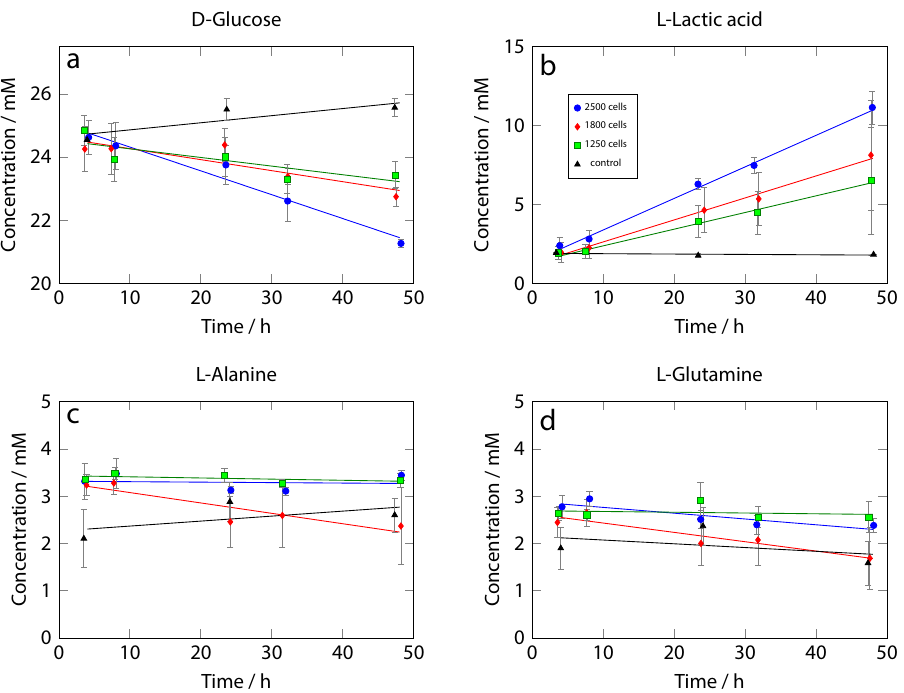
Figure 5. Metabolite concentrations over time in single spheroid culture as a function of time. d-Glucose (a) , l-Lactic acid (b) , l-Alanine (c) , and l-Glutamine (d) changes in 2.5 µ L volume. Error bars represent twice the standard deviation of three separate